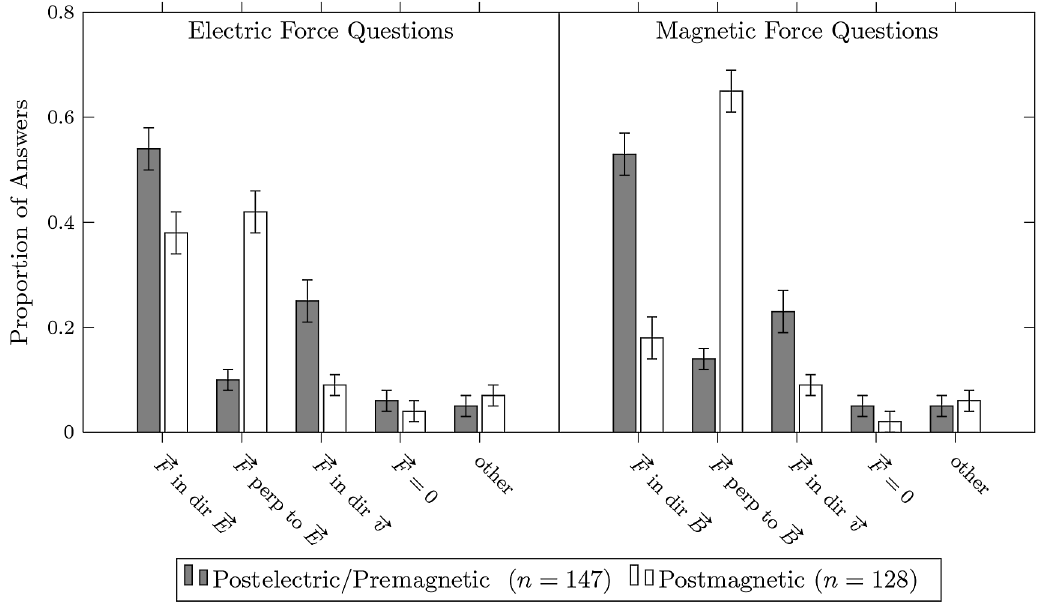
FIG. 5. Results showing how students’ answers to electric and magnetic force questions changed from before to after instruction in magnetism. Fields were depicted using field